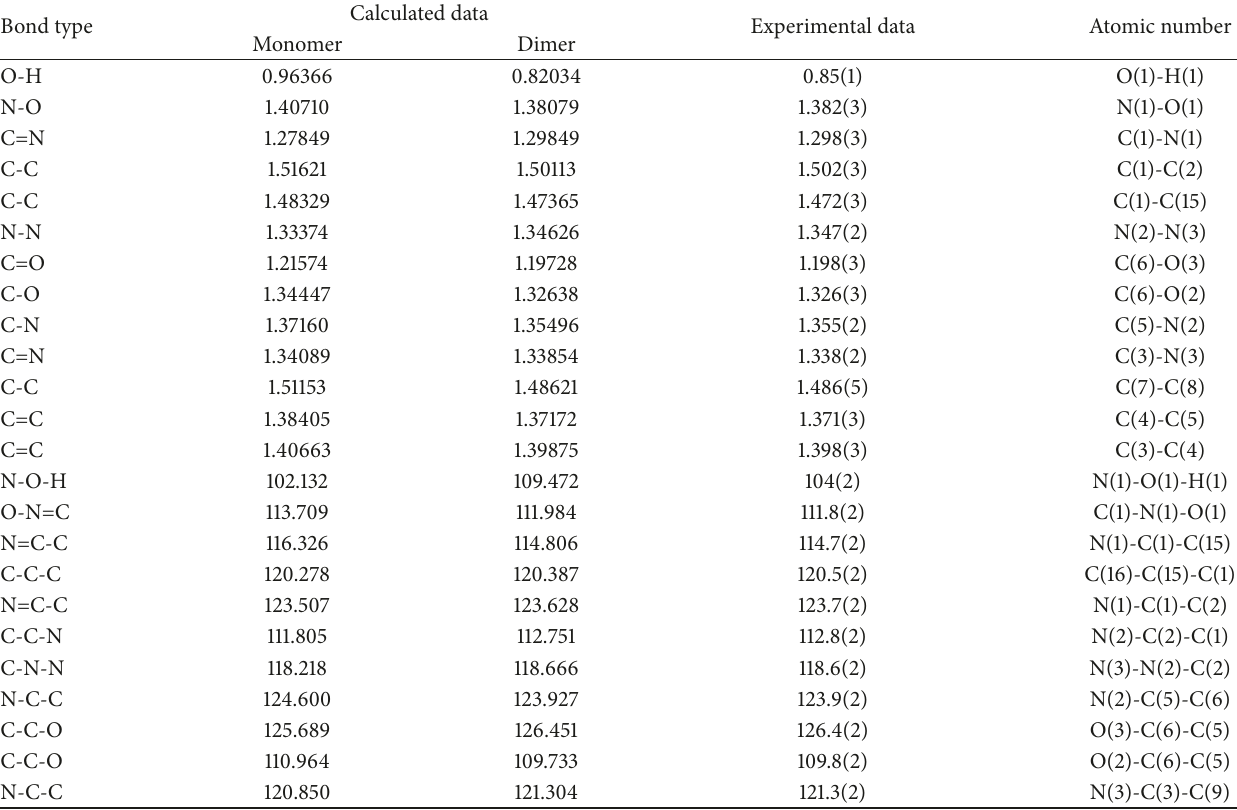
Table 3: Selected experimental and theoretical geometrical parameters of title